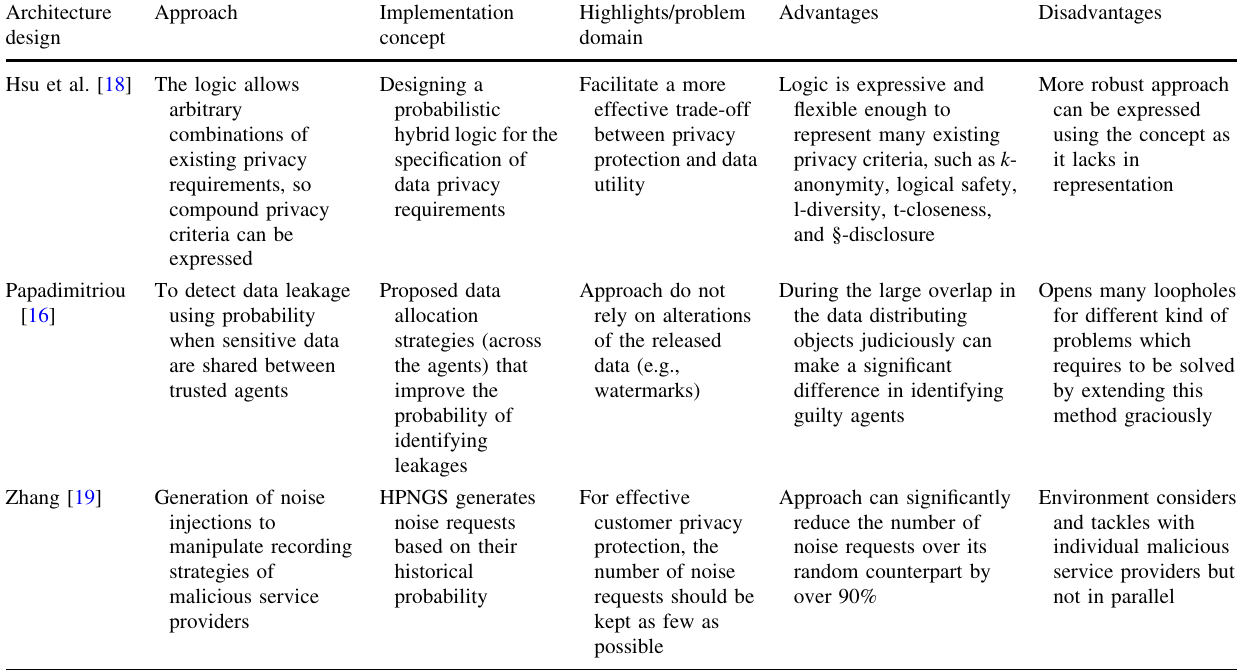
Table 3 Comparison of probability-based evaluation approaches Architecture